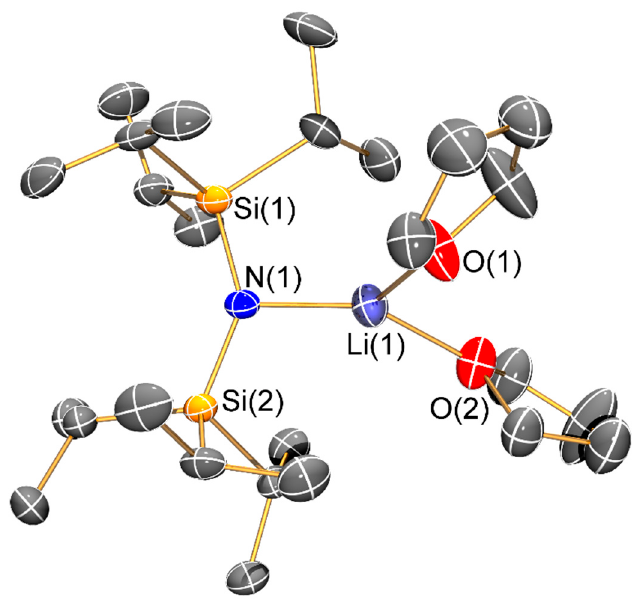
Figure 8. Molecular structure of [Li{N(Si i Pr 3 ) 2 }(THF) 2 ] ( 8 ) with selective atom labelling. Displacement ellipsoids set at 30% probability level and hydrogen atoms omitted for clarity.